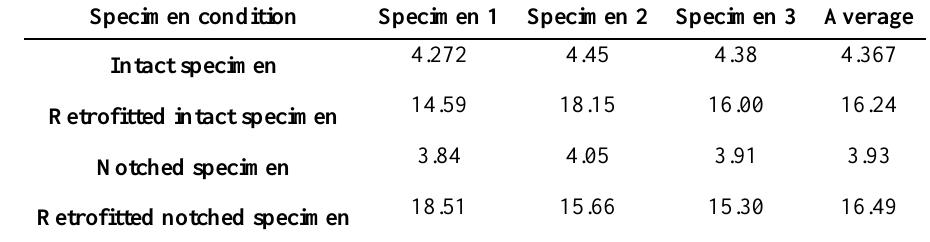
Flexural strength of the tested specimens (MPa).